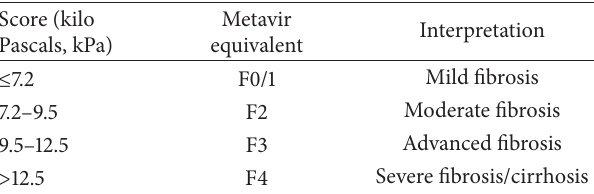
Table3:CriteriaforinterpretationoftransientelastographyinHIV- HCV coinfected patients [115,